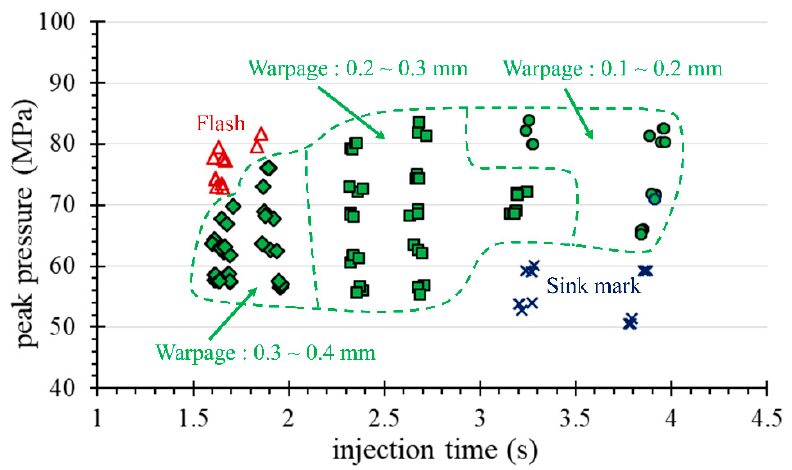
Figure 14. The warpage quality contour of the molded part corresponding to the P1 peak pressure and the injection time.